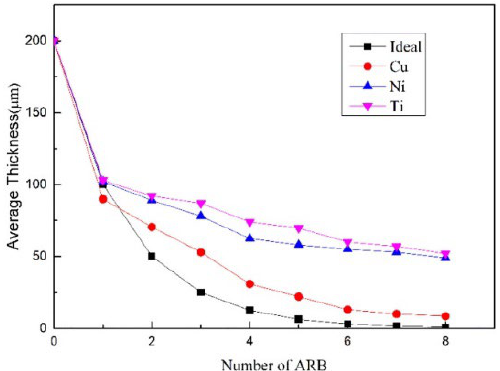
Figure 15. Variations of layer thickness versus the number of ARB passes reprinted with permission from Ref. [50]. Copyright 2022, ELSEVIER.